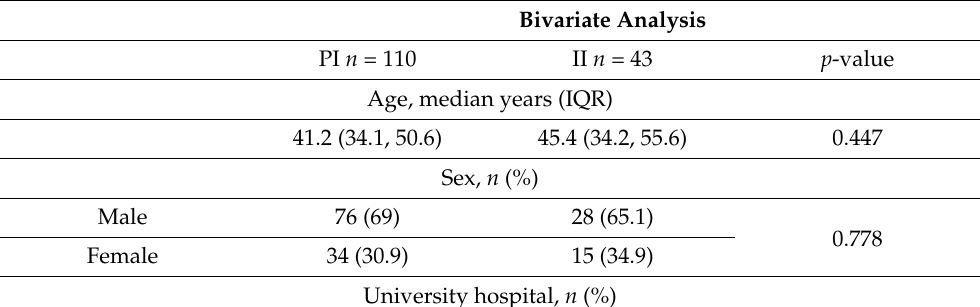
Table 3. Bivariate analysis of preferences for the use of continuous or prolonged